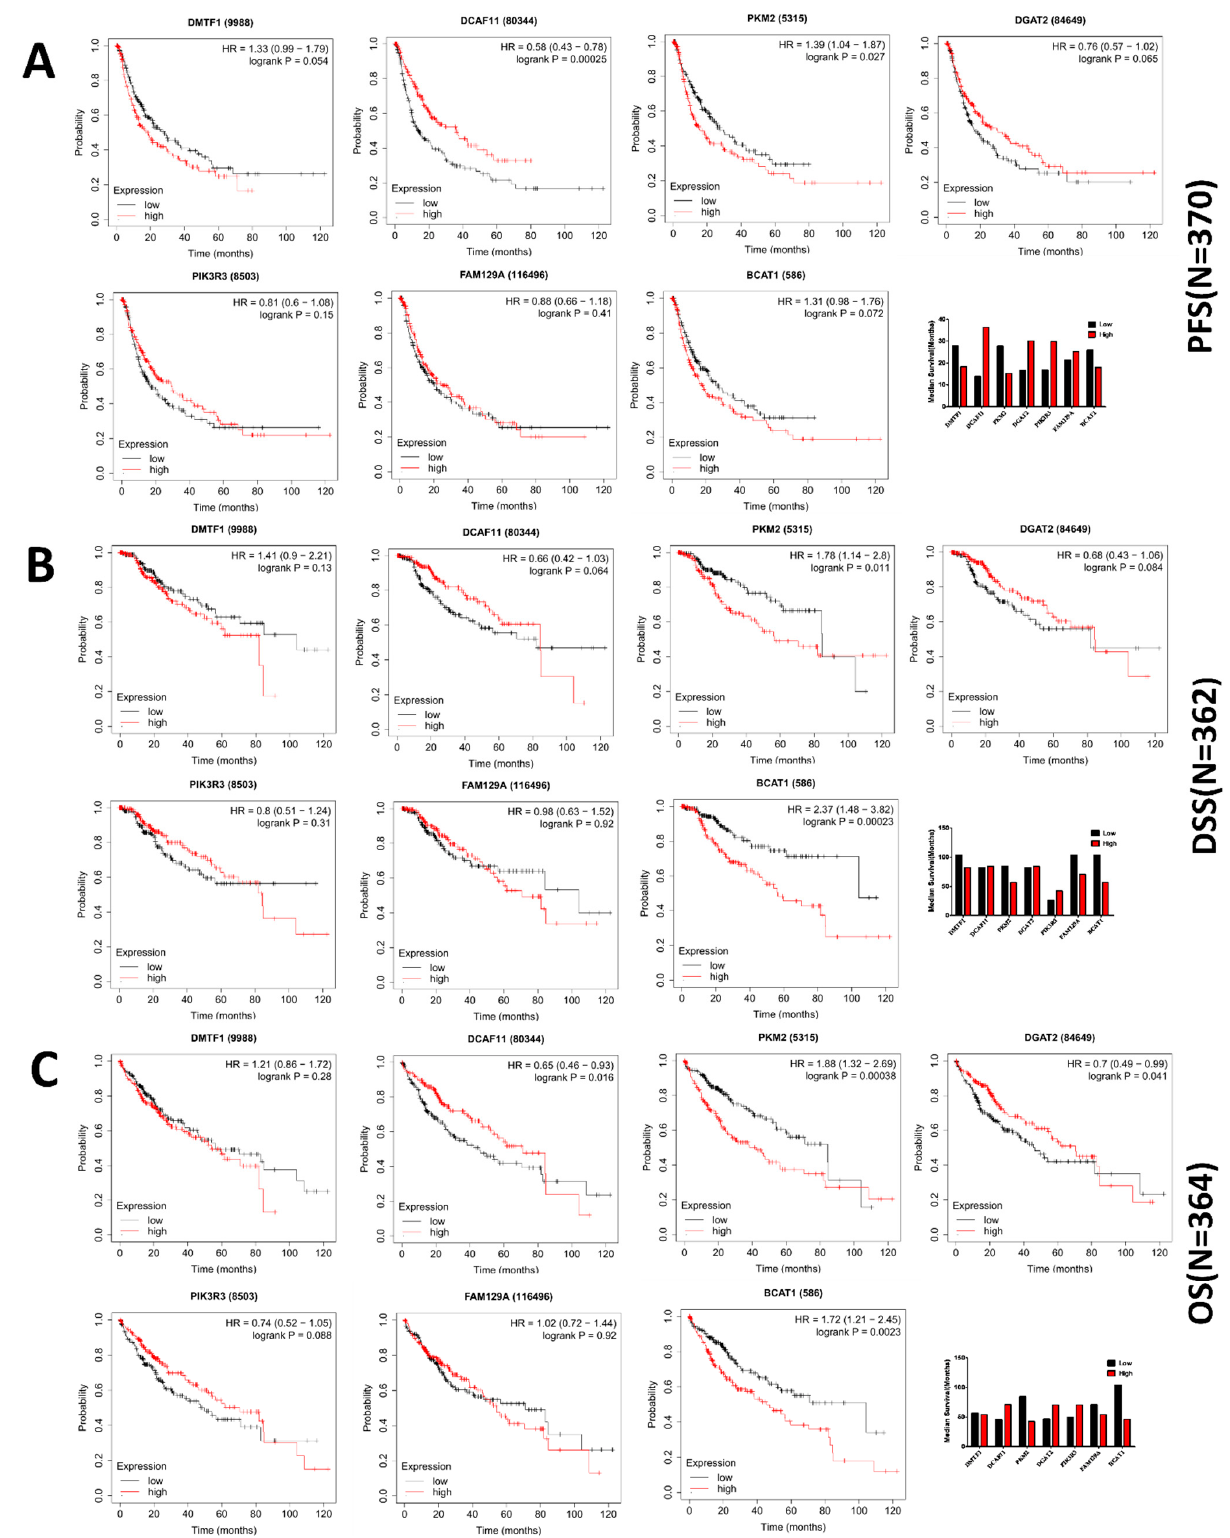
Figure 8. Selected genes in the HCC-AILD GRN show promising prospect as biomarkers as well as therapeutic targets. Kaplan–Meier survival plots of hub genes (genes with ≥ 4 links) displaying ( A ) progression free survival (PFS), ( B ) disease specific survival (DSS) and ( C ) overall survival (OS). N denotes the number of cases considered for each calculation. Analyzed on KM plotter. Bar diagrams at the bottom right indicate median survival for high and low expression conditions of individual